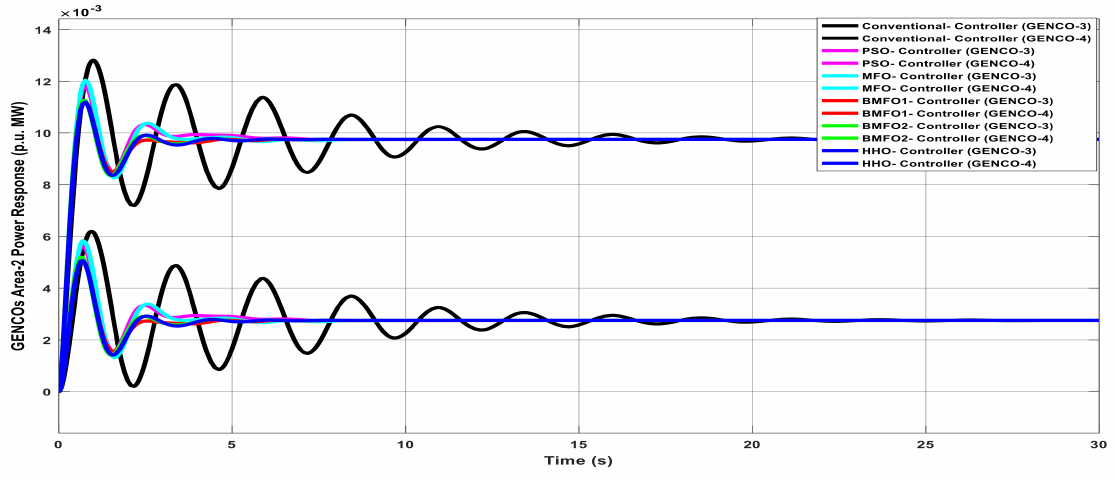
Figure 14. GENCOs generation response of Area2 with various controllers under bilateral contract.